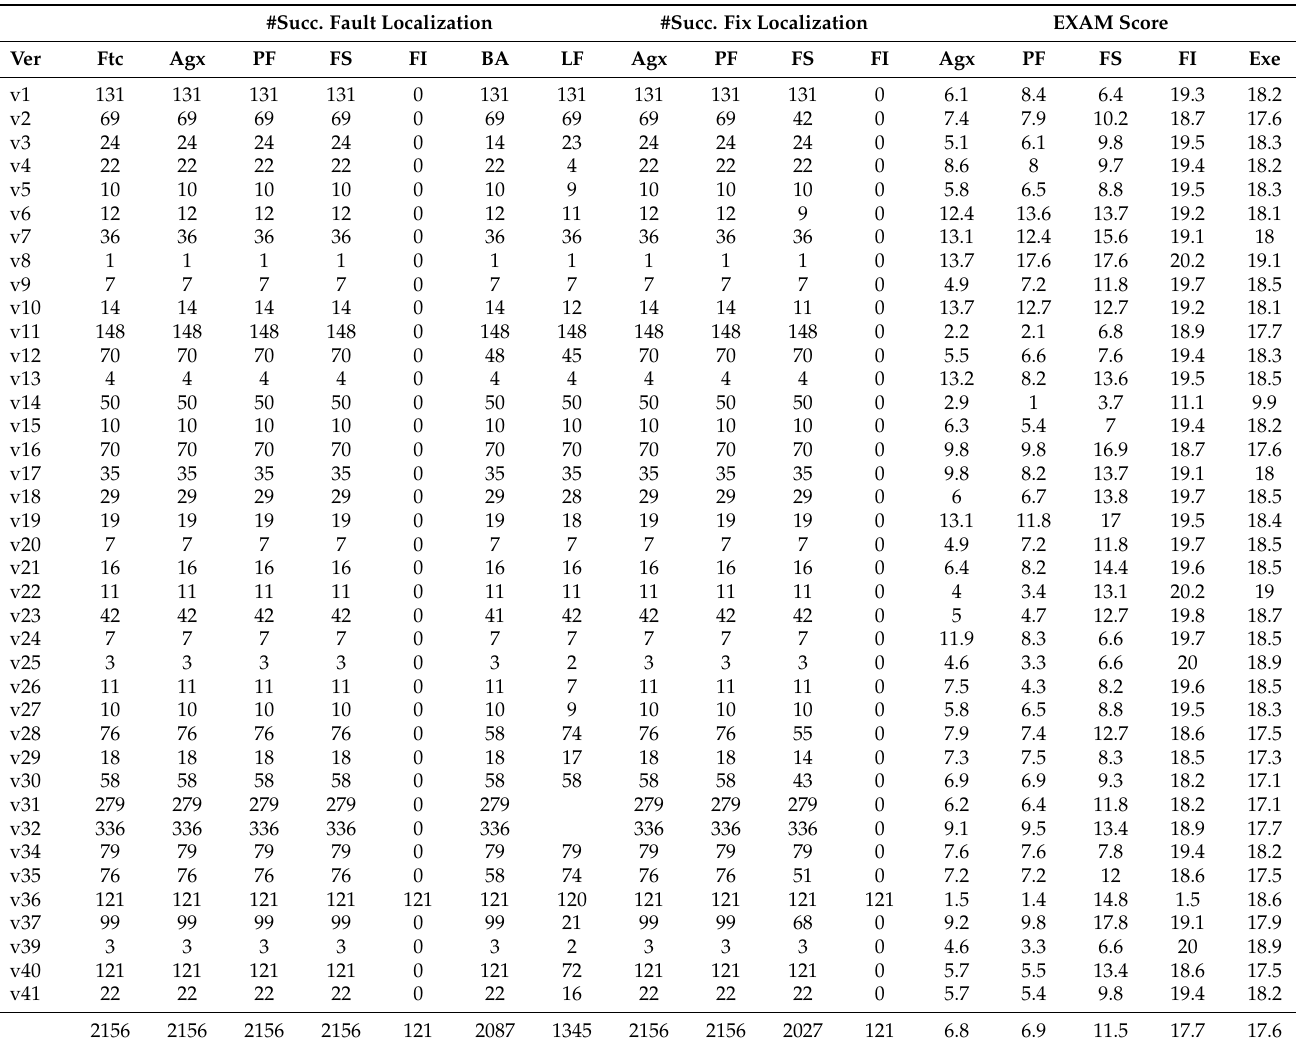
Table 2. Comparison of the effectiveness in identifying fault locations of AgxFaults (Agx), Program Formula (PF), Single Path Control-Flow Sensitive (FS), Control-Flow Insensitive (FI), Bug-Assist (BA), and LocFaults (LF) approaches on the TCAS